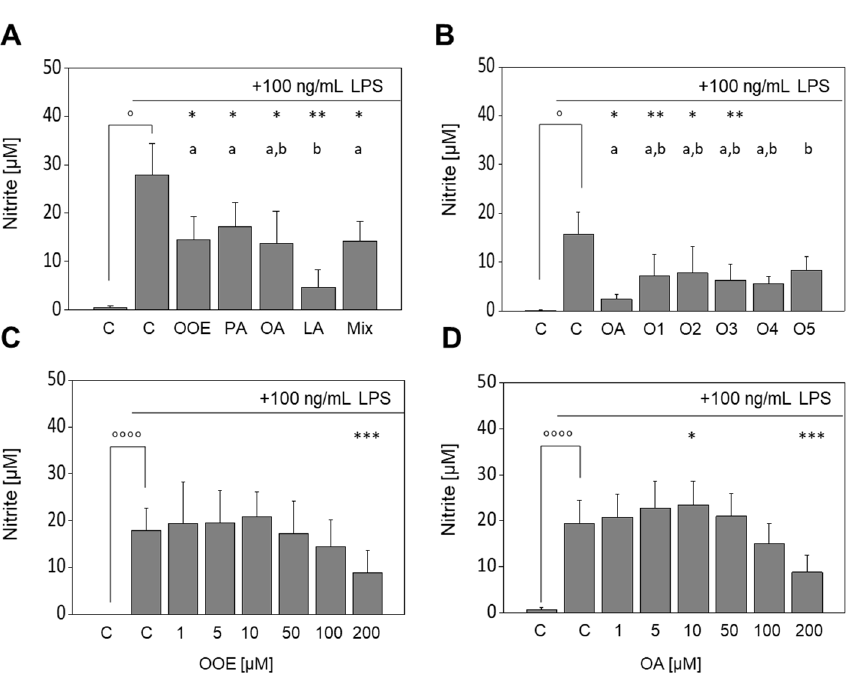
Figure 3. Effects of fatty acids (FA) and olive oil extracts (OOE) on the LPS-induced formation of nitric oxide. Release of nitric oxide measured as nitrite using the Griess assay in LPS-stimulated RAW264.7 macrophages was differentially affected by OOE (O1 to O5) and FA. Cells were pre-incubated with serum-free medium, OOE, oleic acid (OA), linoleic acid (LA), palmitic acid (PA), or of a defined FA mixture (Mix) of the mentioned FAs (80:10:10) for 4 h followed by a co-incubation with 100 ng/mL LPS for additional 20 h ( A ). Cells were pre-incubated with serum-free medium, 200 µ M of the five different OOEs (O1 to O5) or 200 µ M OA for 4 h followed by a co-incubation with 100 ng/mL LPS with medium, 200 µ M OOEs or 200 µ M OA for an additional 20 h ( B ). Cells were pre-incubated with medium, 1–200 µ M OOE ( C ), or 1–200 µ M OA ( D ) for 4 h followed by a co-incubation with 100